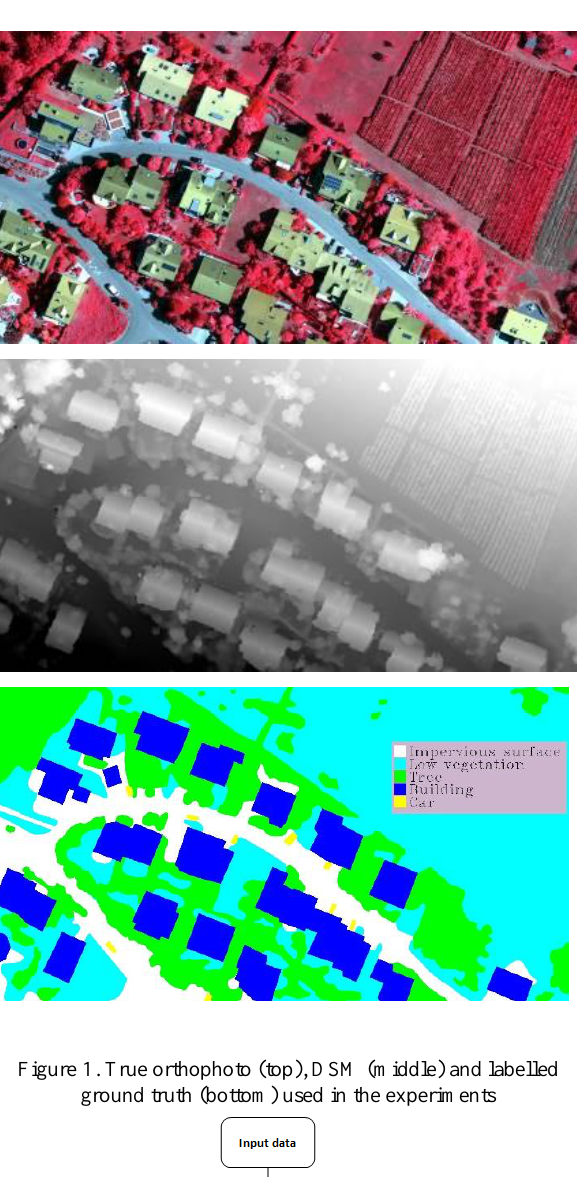
Figure 1. True orthophoto (top), DSM (middle) and labelled ground truth (bottom) used in the experiments